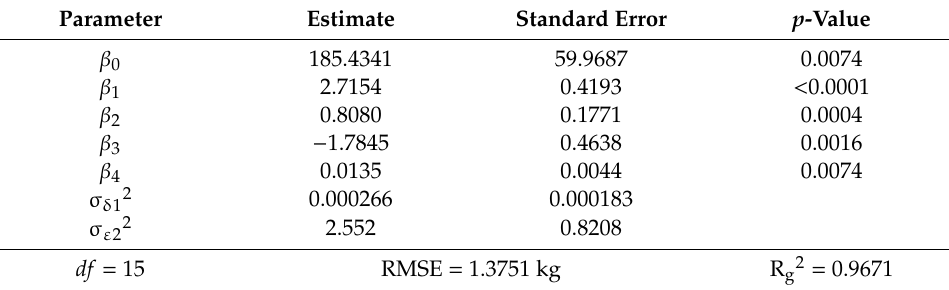
Table 4. Parameters, estimates, standard error, and p -values for the final tree-level foliage mass model (Equation